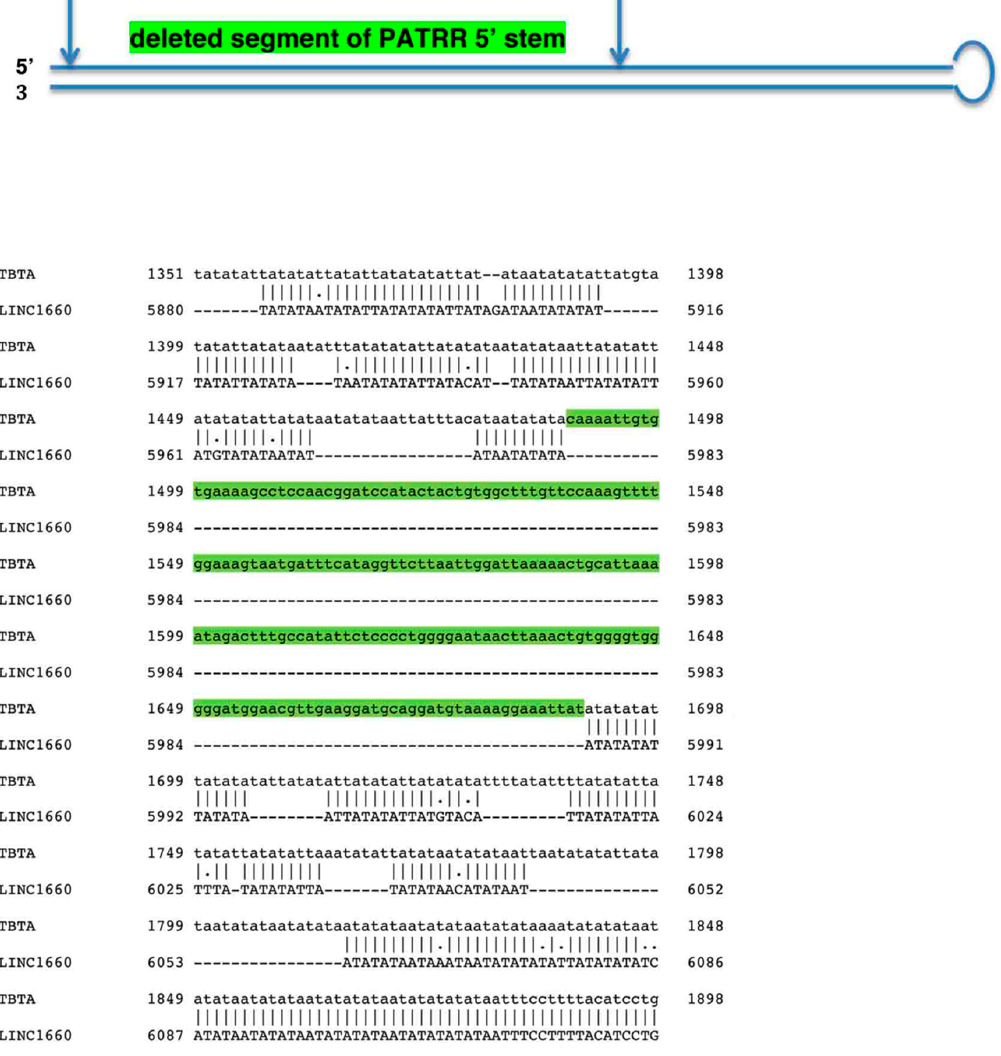
Figure 3. ( Top ) Schematic of PATRR stem loop. The section between arrows denote sequences from the 5’ half missing in gene LINC01660. ( Bottom ) Alignment of the nucleotide sequences of the TBTA and L INC01660 . The alignment was determined by the Emboss Needle Pairwise Sequence